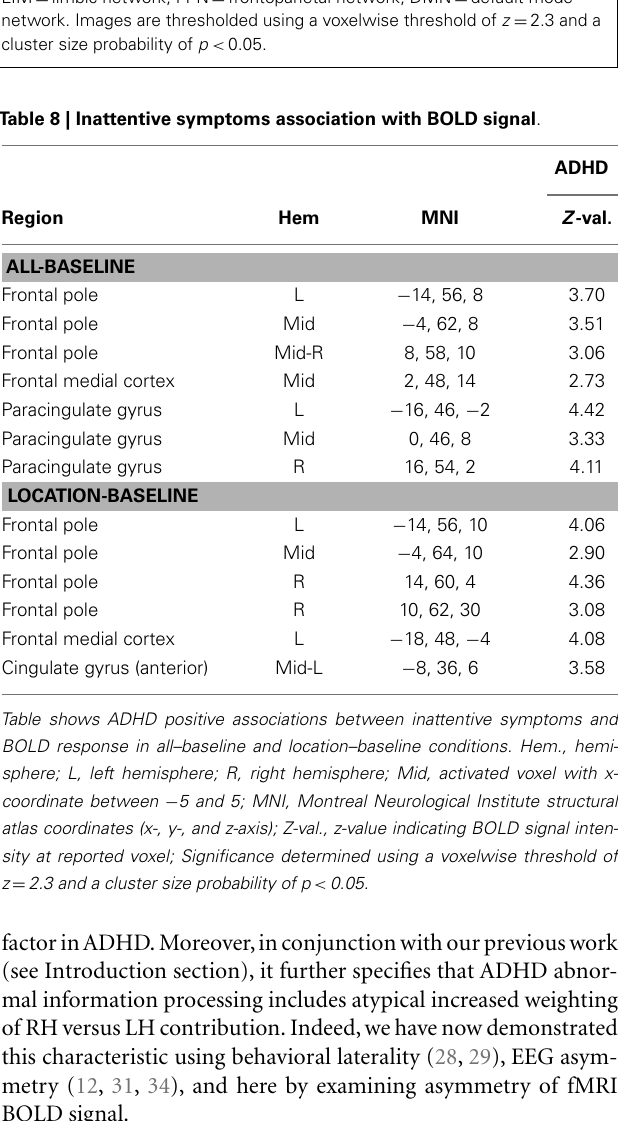
FIGURE 5 |Attention-deficit hyperactivity disorder visual network asymmetry association with BOLD signal during the letter task . ADHD subjects showed exclusive positive associations between visual network asymmetry (VN-AI) during the letter task and BOLD response across multiple brain regions, likely reflective of DMN activation.These ADHD-exclusive associations produced significant group differences.The upper row shows